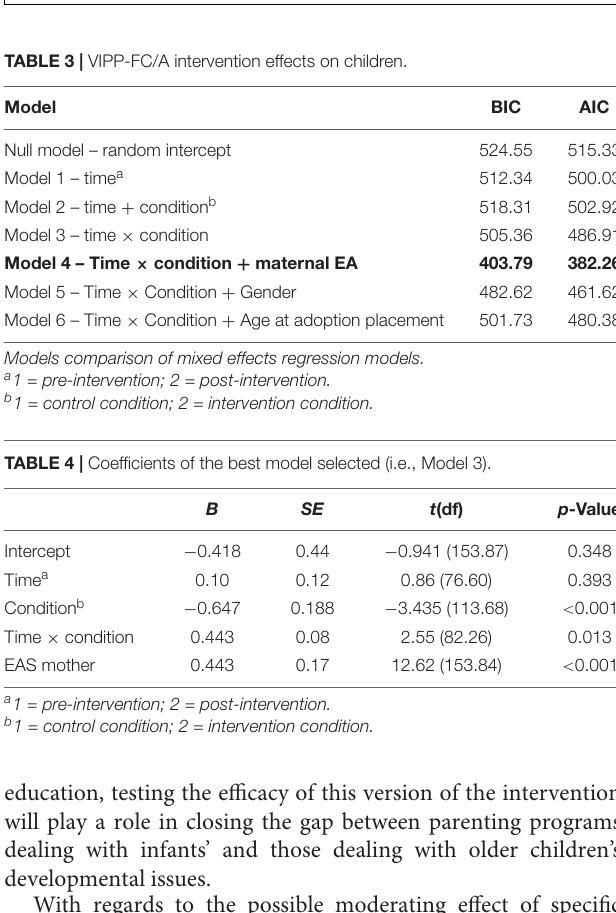
FIGURE 2 | Intervention condition effect on positive parenting. Condition 1 refers to the dummy intervention; Condition 2 to the VIPP intervention condition.